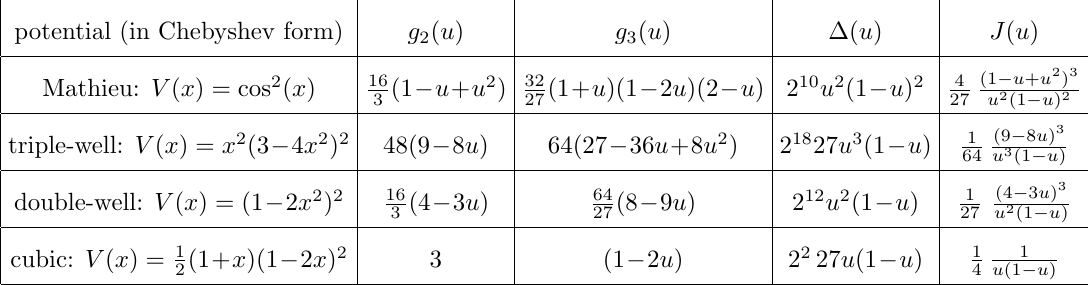
Table 6 . Uniformizing elliptic curve data for the four arithmetic Chebyshev potentials. The modular J ( u ) functions are used in table 4 for a comparison with associated mirror curve properties in table